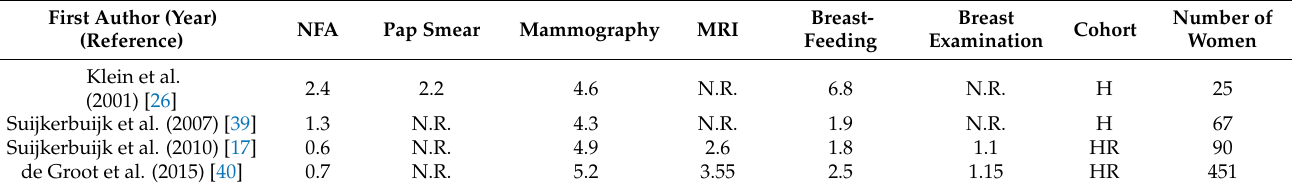
Table 1. Reported mean discomfort rates (on a scale from 0–10) for NFA (nipple fluid aspiration) compared to pap smear, mammography, breast magnetic resonance imaging (MRI), breastfeeding and breast examination. Abbreviations: N.R., not reported; H, healthy female volunteers; HR: women at high risk of developing breast